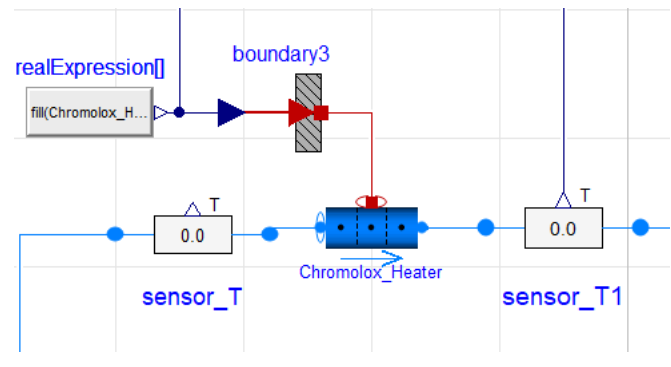
Figure 6. Chromalox heater.